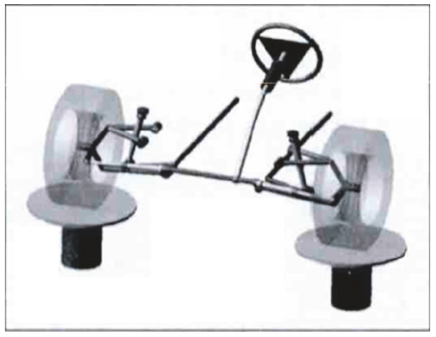
Figure 4: The dynamic model of front suspension and steering system by ADAMS.